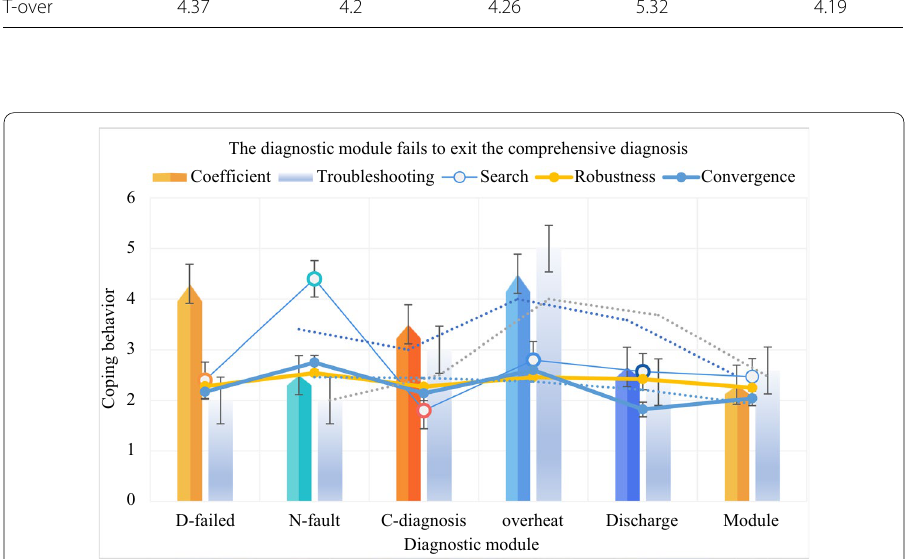
Fig. 15 The diagnostic module fails to exit the comprehensive diagnosis